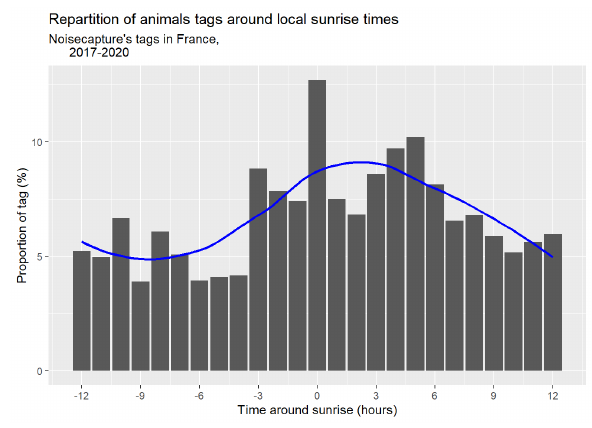
Figure 3. Road acoustics